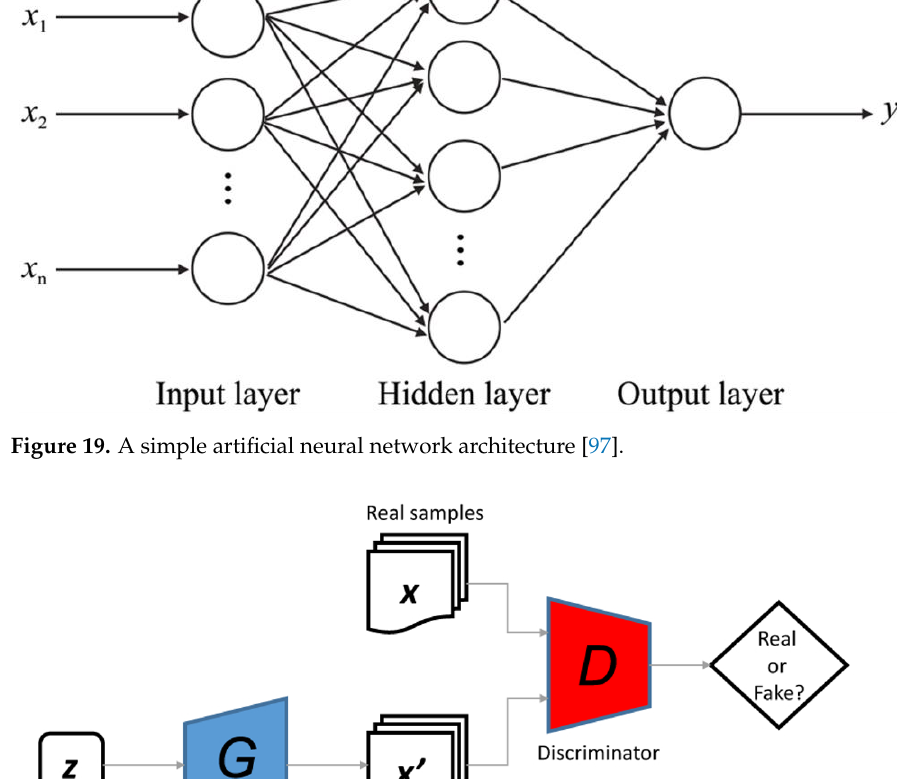
Figure 19. A simple artificial neural network architecture [97].